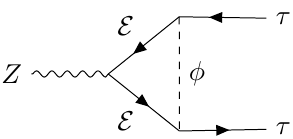
Figure 3. Vertex corrections to Z couplings with (cid:28) and (cid:23) (cid:28) as a result of the new particles. Cancellation of divergences necessitates the inclusion of diagrams with Goldstone